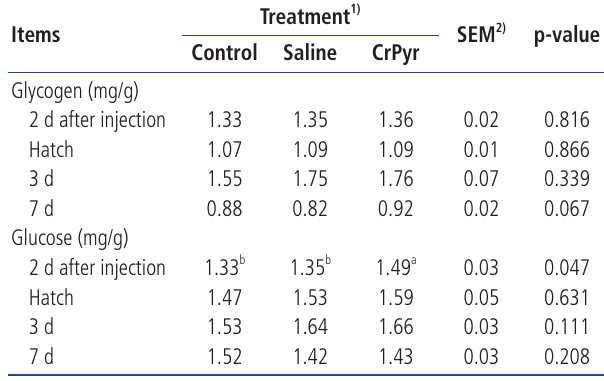
Table 3. Effects of in ovo feeding of creatine pyruvate on the concentration of glycogen and glucose in thigh muscle of embryos and broilers on 2 d after injection, the day of hatch, 3, and 7 d post-hatch Product GeneBank size (bp) Identification Treatment 1) Items SEM 2)